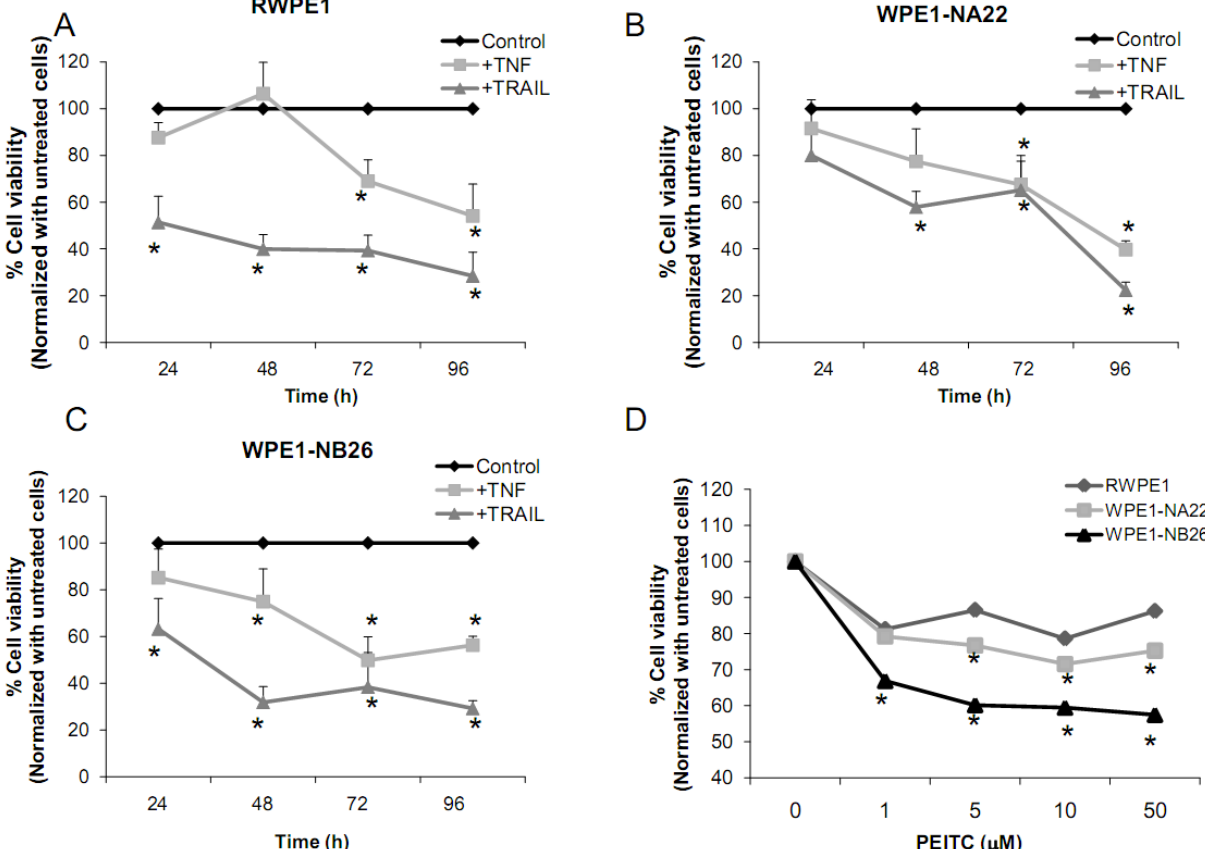
Figure 7. Effects of TNF, TRAIL, or PEITC on cell viability of RWPE1, WPE1-NA22, or WPE1-NB26 cells. ( A ) RWPE1; ( B ) WPE1-NA22, or ( C ) WPE1-NB26 cells were